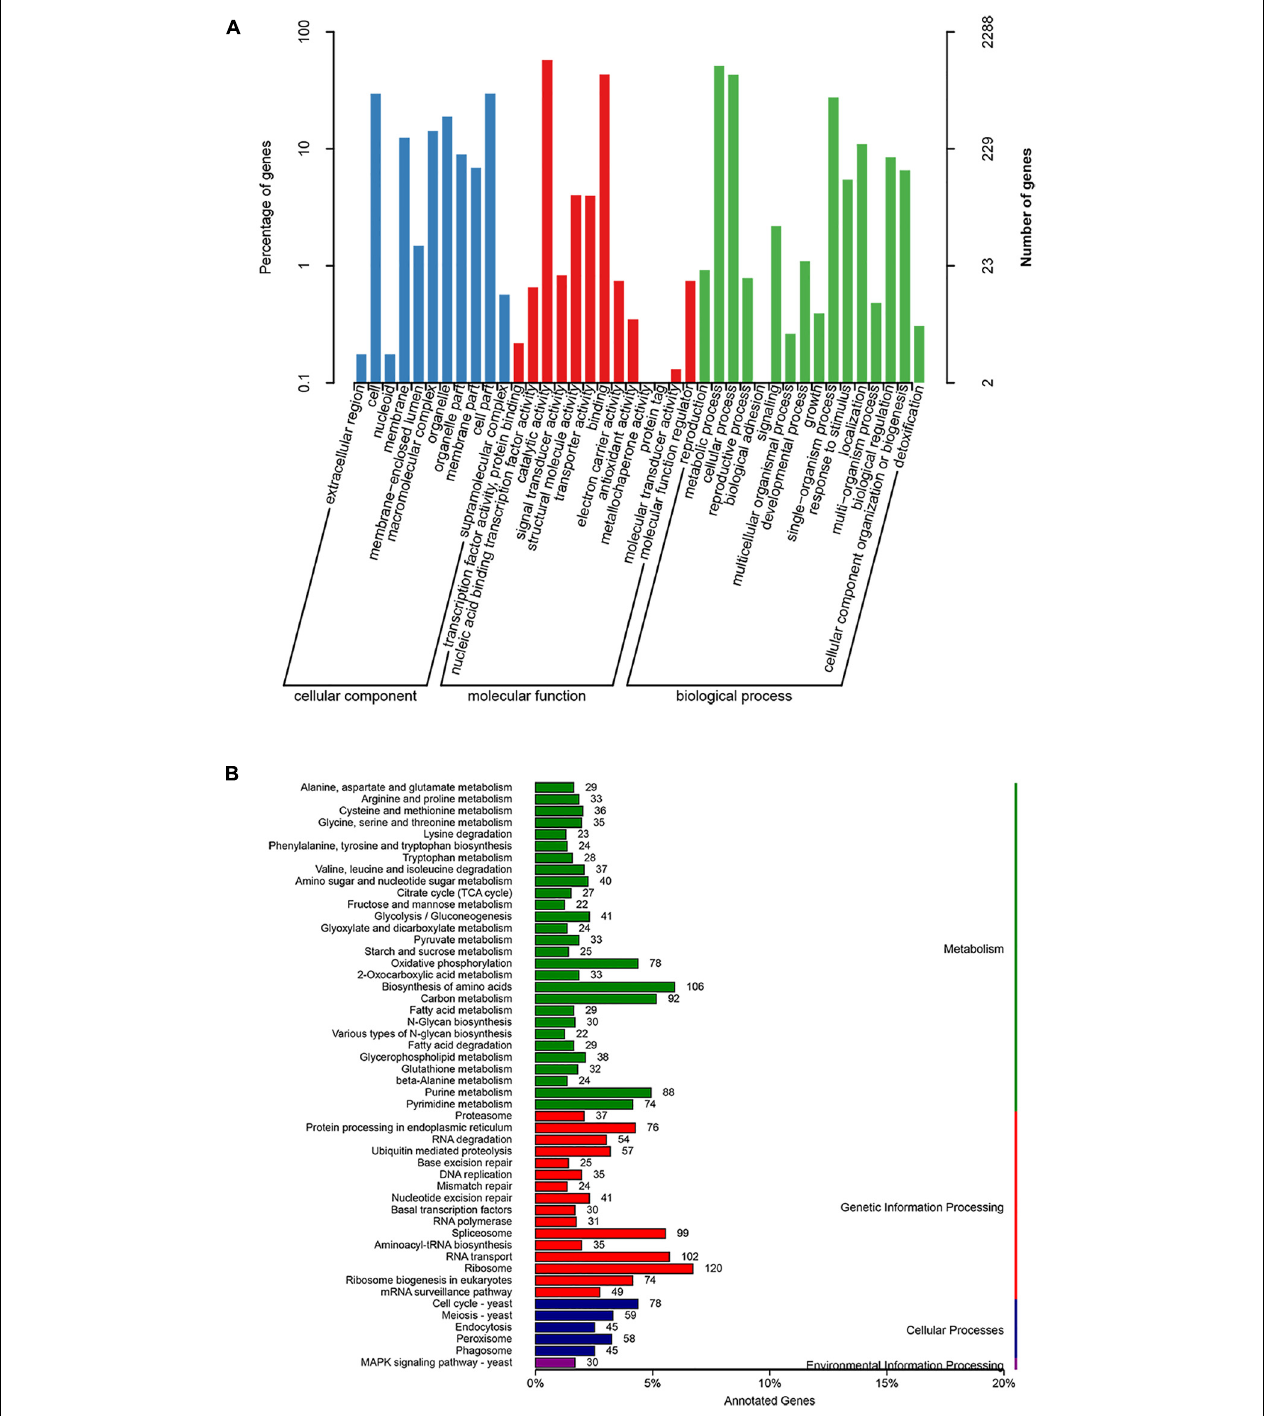
FIGURE 2 | Gene ontology (GO) and Kyoto Encyclopedia of Genes and Genomes (KEGG) classifications of proteins in R. kratochvilovae strain YM25235. Distribution of predicted proteins from R. kratochvilovae strain YM25235 genome by (A) GO and (B) KEGG databases.